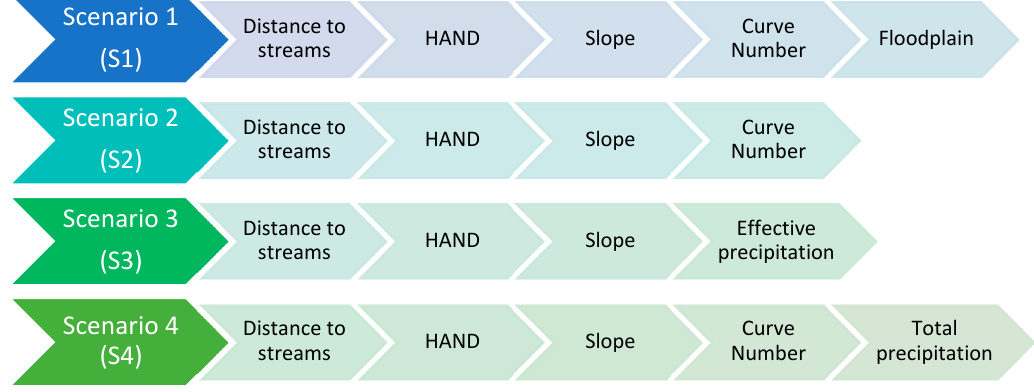
Figure 5. Scenarios varying in criteria for flood hazard.